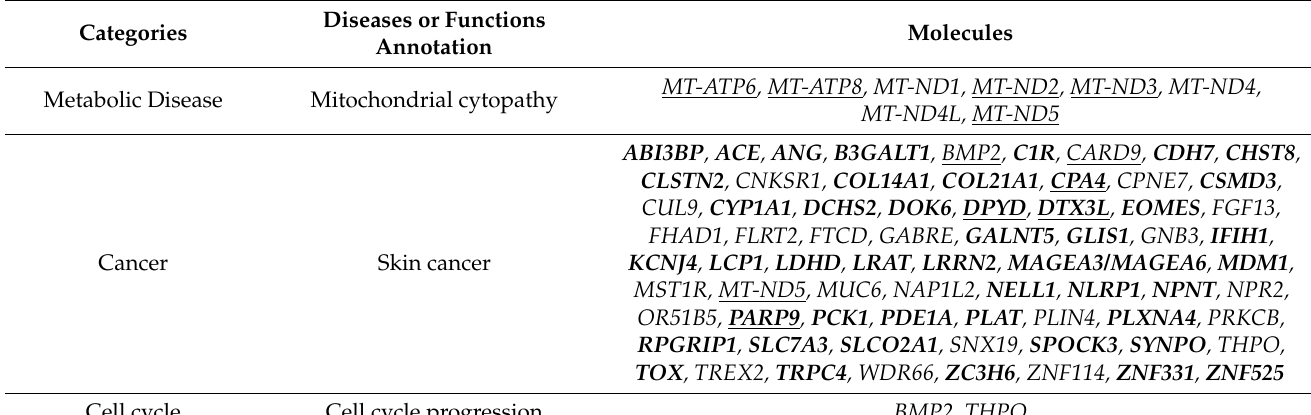
Figure 7. RNA sequencing analysis of LentiBRCT and Lentiluc HEK293T infected cells. Heatmap of the 192 dysregulated genes in lentiBRCT (BRCT) infected HEK293T cells compared to lentiluc (LUC) infected cells. The experiment was performed in triplicate ( A ). Molecular categories from Ingenuity pathway Analysis of the 192 dysregulated genes in lentiBRCT infected HEK293T cells compared to lentiluc infected cells. The graph presents the molecular categories ordered by –log ( p value) and the number of genes from our list of 192 dysregulated that are in each specific category (in the right part of the bars) ( B ). Table 2. Ingenuity pathway analysis of differentially expressed mRNAs in BRCT domain from LmjPES protein expressing HEK293T cells compared to control cells.